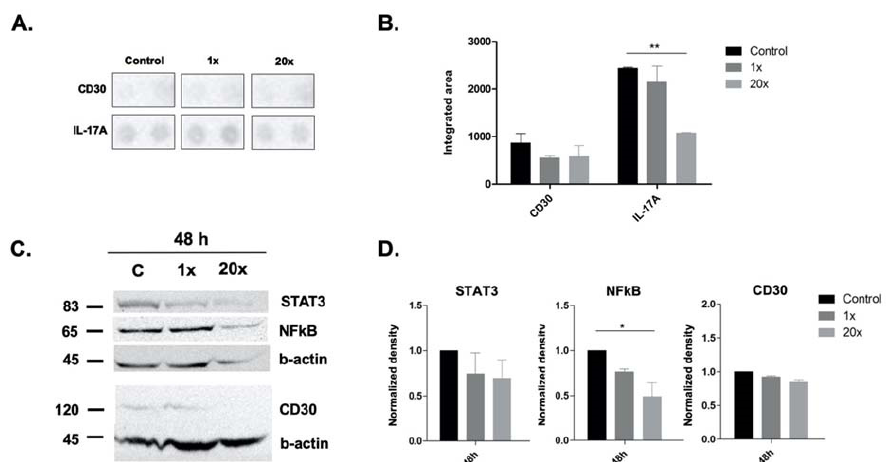
Figure 5. Cytokine array and Western blot analysis of inflammation-related markers in Panc-1 cell line. Significantly decreased level of IL-17a measured by cytokine array and NFkB by Western blot were detected after 48 h of 20 × methyl-donor treatment ( A – D ). Decreased protein level of CD30 did not reach significance after 48 h methyl-donor treatment, either by cytokine array ( A , B ) or by Western blot, similar to STAT3 protein level ( C , D ). Each bar represents the average normalized density from at least 3 repeats ± SD. Statistical significance are plotted as *: p < 0.05; **: p < 0.01. 1 × and 20 × : concentration of methyl